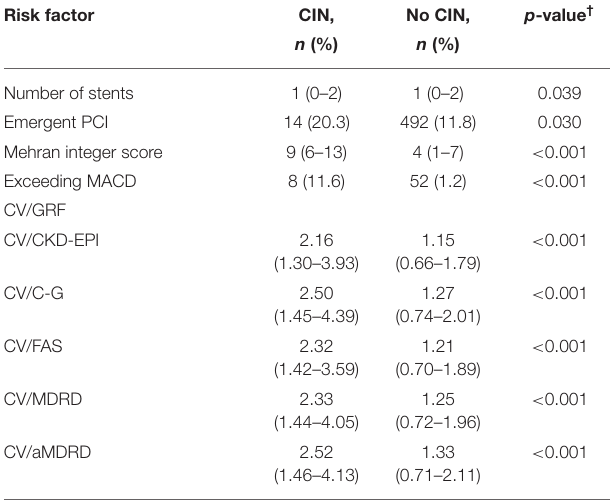
TABLE 1 | Baseline characteristics of patients who developed